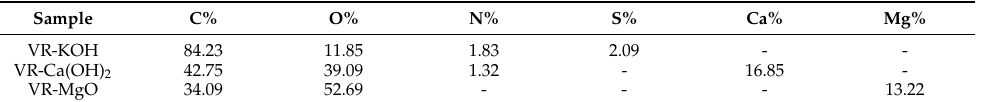
Table 2. Elemental composition of VR-KOH, VR-Ca(OH) 2 , and VR-MgO estimated from XPS data.